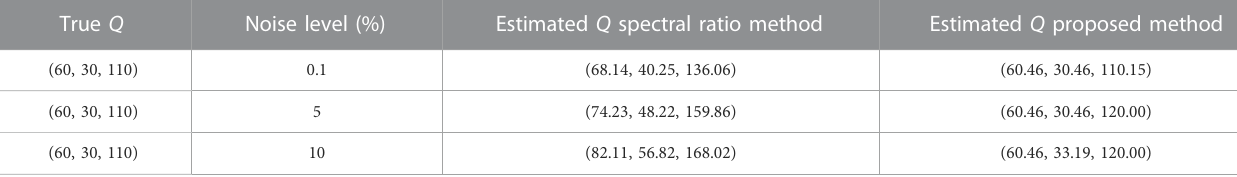
TABLE 1 The results of the Q estimation by different methods, corresponding to the synthetic traces shown in Figures 6A – C. True Q Noise level